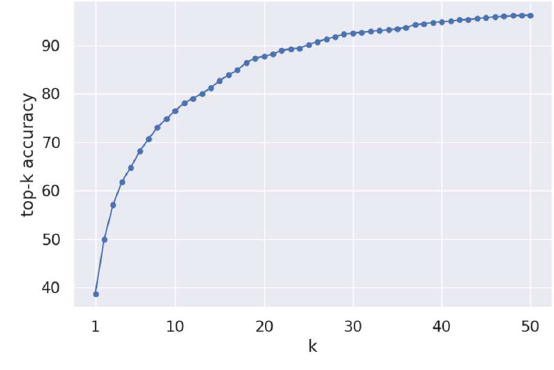
Figure 7. CMC plot of top- k accuracies for all k in [1, 2, …, 50] on the test set counting 515